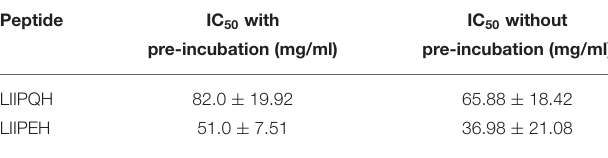
TABLE 3 | Stability of RWLE peptides toward ACE. Peptide IC 50 with IC 50